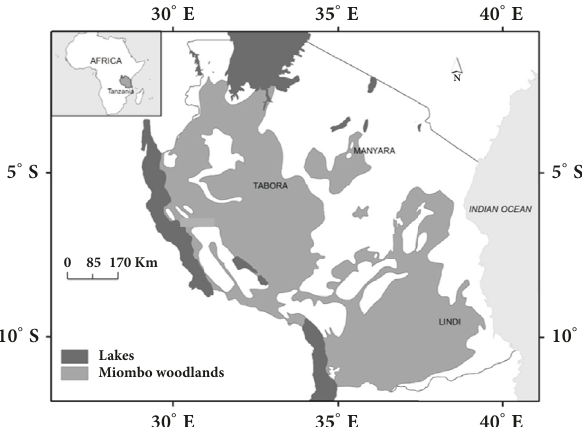
Figure 1: Study sites (Manyara, Lindi, and Tabora) locations as seen in the map of Tanzania. Modified from